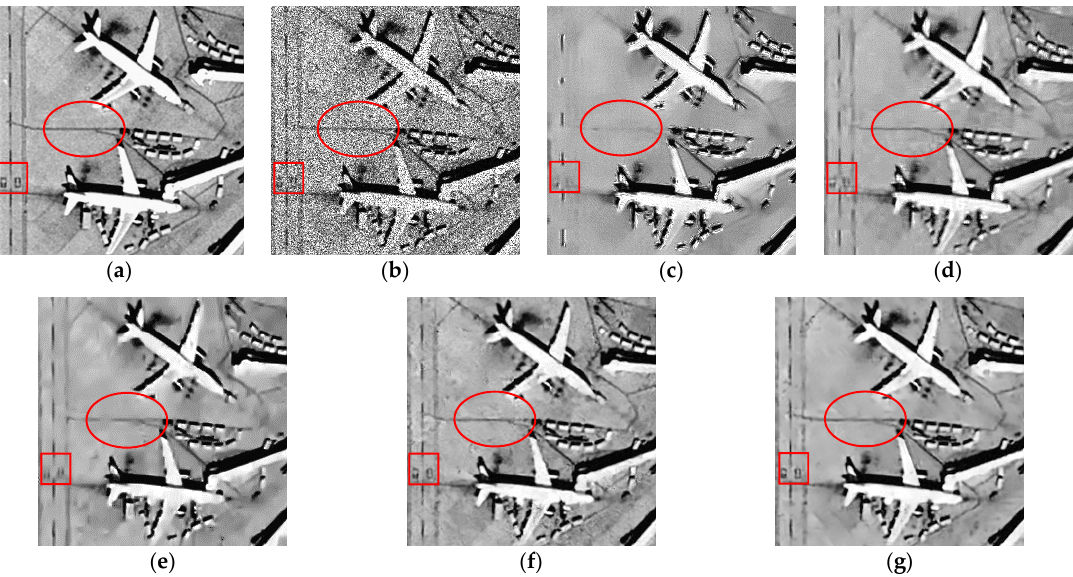
Figure 6. Filtered images for the Airplane image contaminated by two-look speckle. ( a ) Original image. ( b ) Speckled image. ( c ) PPB [13]. ( d ) SAR-BM3D [14]. ( e ) SAR-POTDF [16]. ( f ) SAR-CNN [28]. ( g ) SAR-DRN.